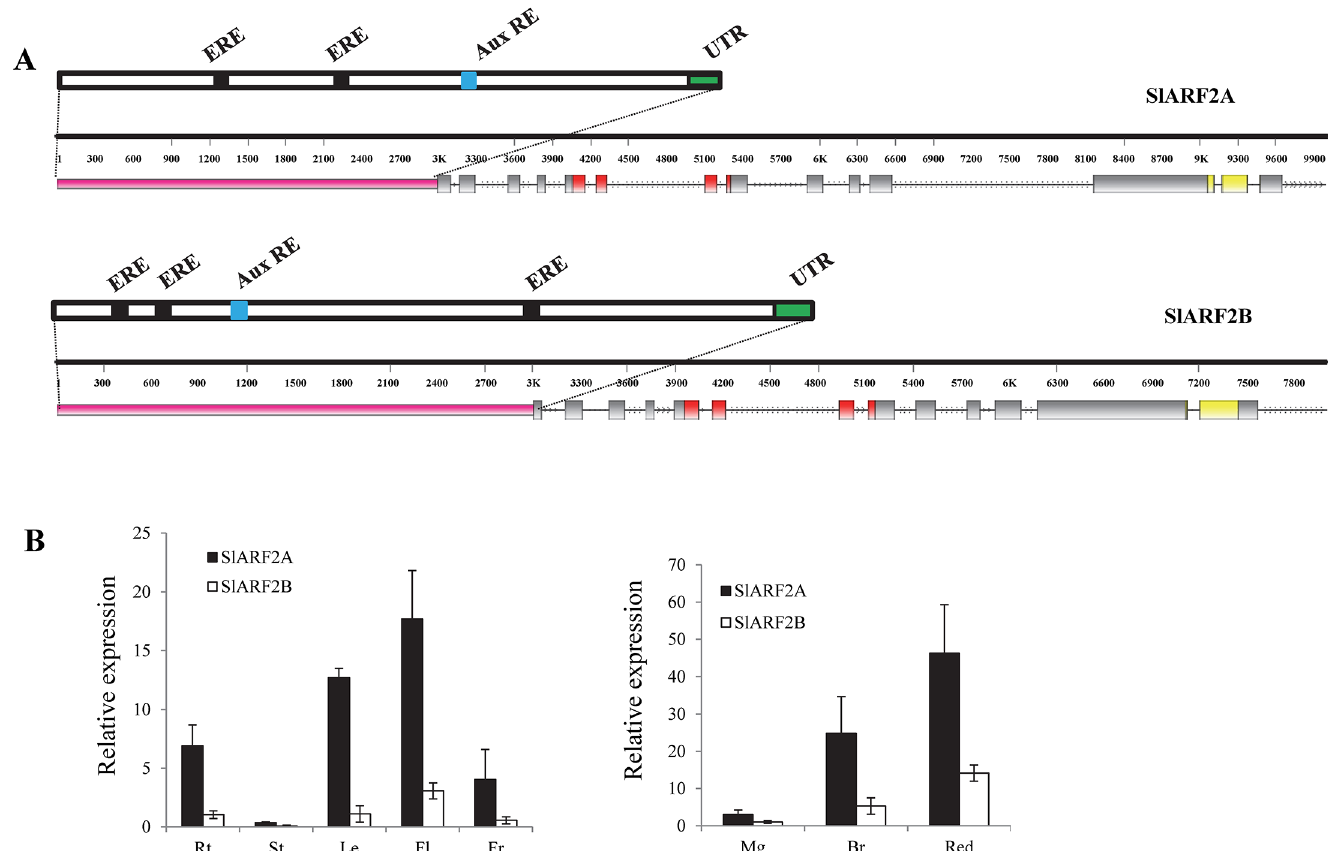
Fig 1. Structural features and expression patterns of tomato SlARF2A and SlARF2B genes. (A) Genomic structure analysis of SlARF2A and SlARF2B genes were drawn using Fancy gene V1.4 software (http://bio.ieo.eu/fancygene/) and SlARF2A SlARF2B iTAG2.40 gene model data. The pink portion represents the promoter region; the strandlines represent intron parts; the gray boxes indicate exon parts; the yellow boxes region responsible for dimerization with Aux/IAA proteins (domain III and IV); the red boxes correspond to the DNA binding domain (DBD); ERE and AuxRE correspond to the ethylene and auxin responsive cis -elements. (B) Expression pattern of SlARF2A/2B monitored by quantitative real-time RT-PCR (qPCR) in total RNA samples extracted from root (Rt), stem (St), leaf (Le), flower (Fl), fruit (Fr), mature green fruit (MG), breaker fruit (Br) and red fruit (Re). Relative mRNA levels corresponding to SlARF2A / SlARF2B genes were normalized against actin in each RNA sample. The relative mRNA levels of SlARF2B in root and at mature green (MG) stage were used as reference (relative mRNA level 1). Error bars mean ± SD of three biological